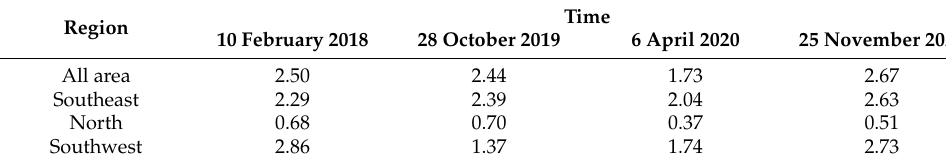
Figure 8. Inversion results of the bathymetry of Wuzhizhou Island. The inversion water depth is in range of 0 − 20 m. ( a ) Inversion result by WV2 remote sensing data on 10/02/2018; ( b ) Inversion result by WV3 remote sensing data on 28/10/2019; ( c ) Inversion result by WV3 remote sensing data on 06/04/2020; ( d ) Inversion result by WV3 remote sensing data on 25/11/2020. Table 4. RMSEs in different areas. Units: m.